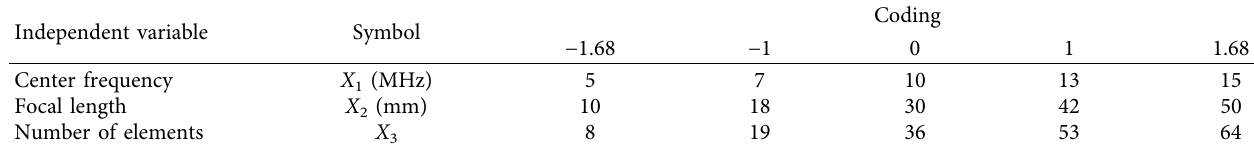
Table 8: CCD test design factors and coding